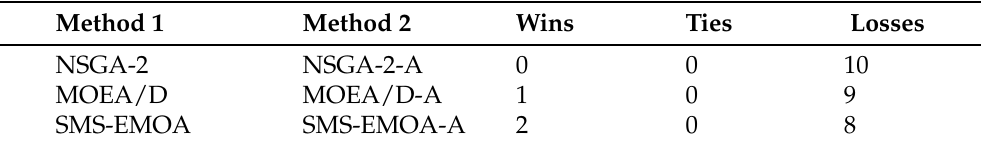
Table 1. Comparison (wins/ties/losses) of the results of the base MOEAs against their archive equipped variants on the bi-objective test problems. The Wilcoxon rank-sum test has been used for statistical significance, where p -value <